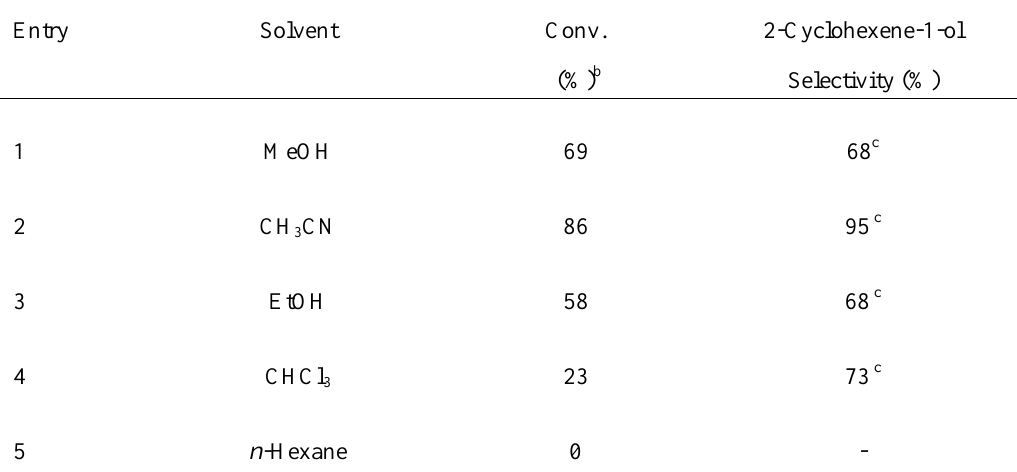
Table 2 . Effect of Solvents on Oxidation of Cyclohexene a